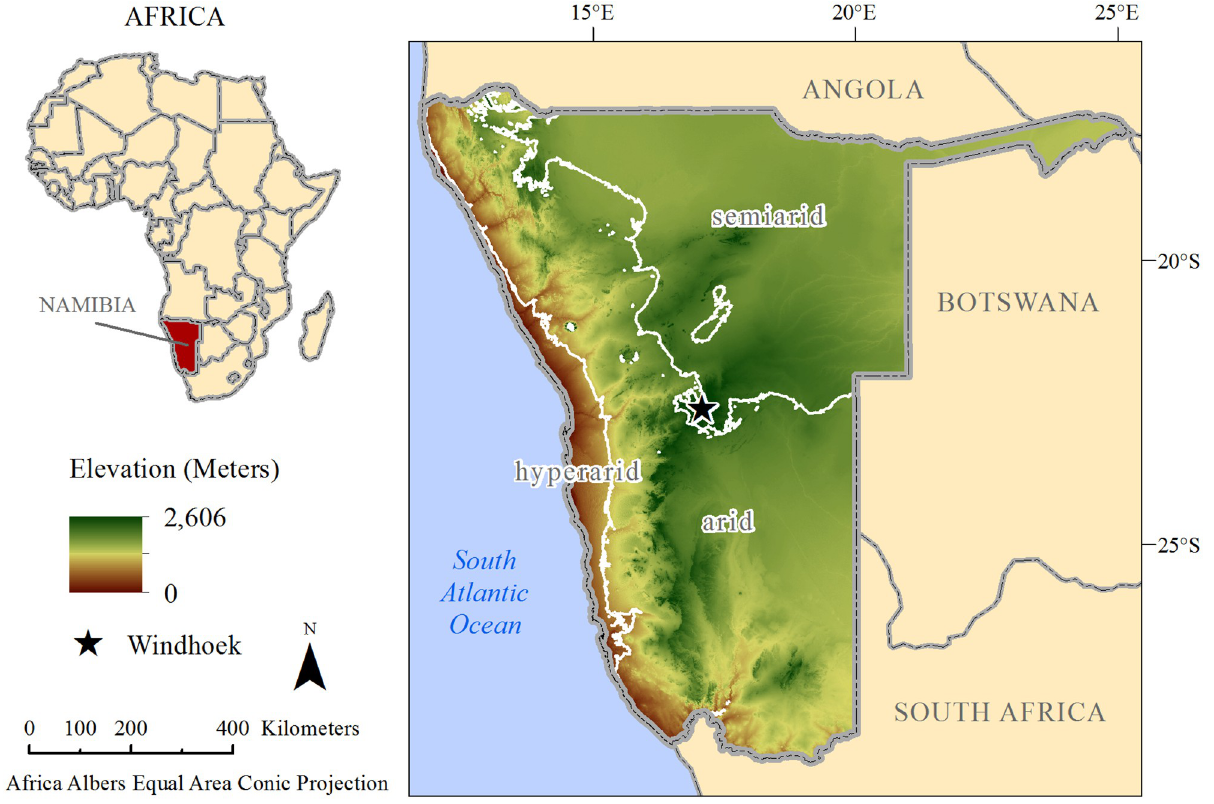
Fig 1. Location and topo-climatic characteristics of Namibia. White lines indicate borders between three aridity zones: semiarid (aridity index ~ 0.2 to 0.371), arid (aridity index ~ 0.03 to 0.2), and hyperarid (aridity index ~ 0.006 to 0.03).